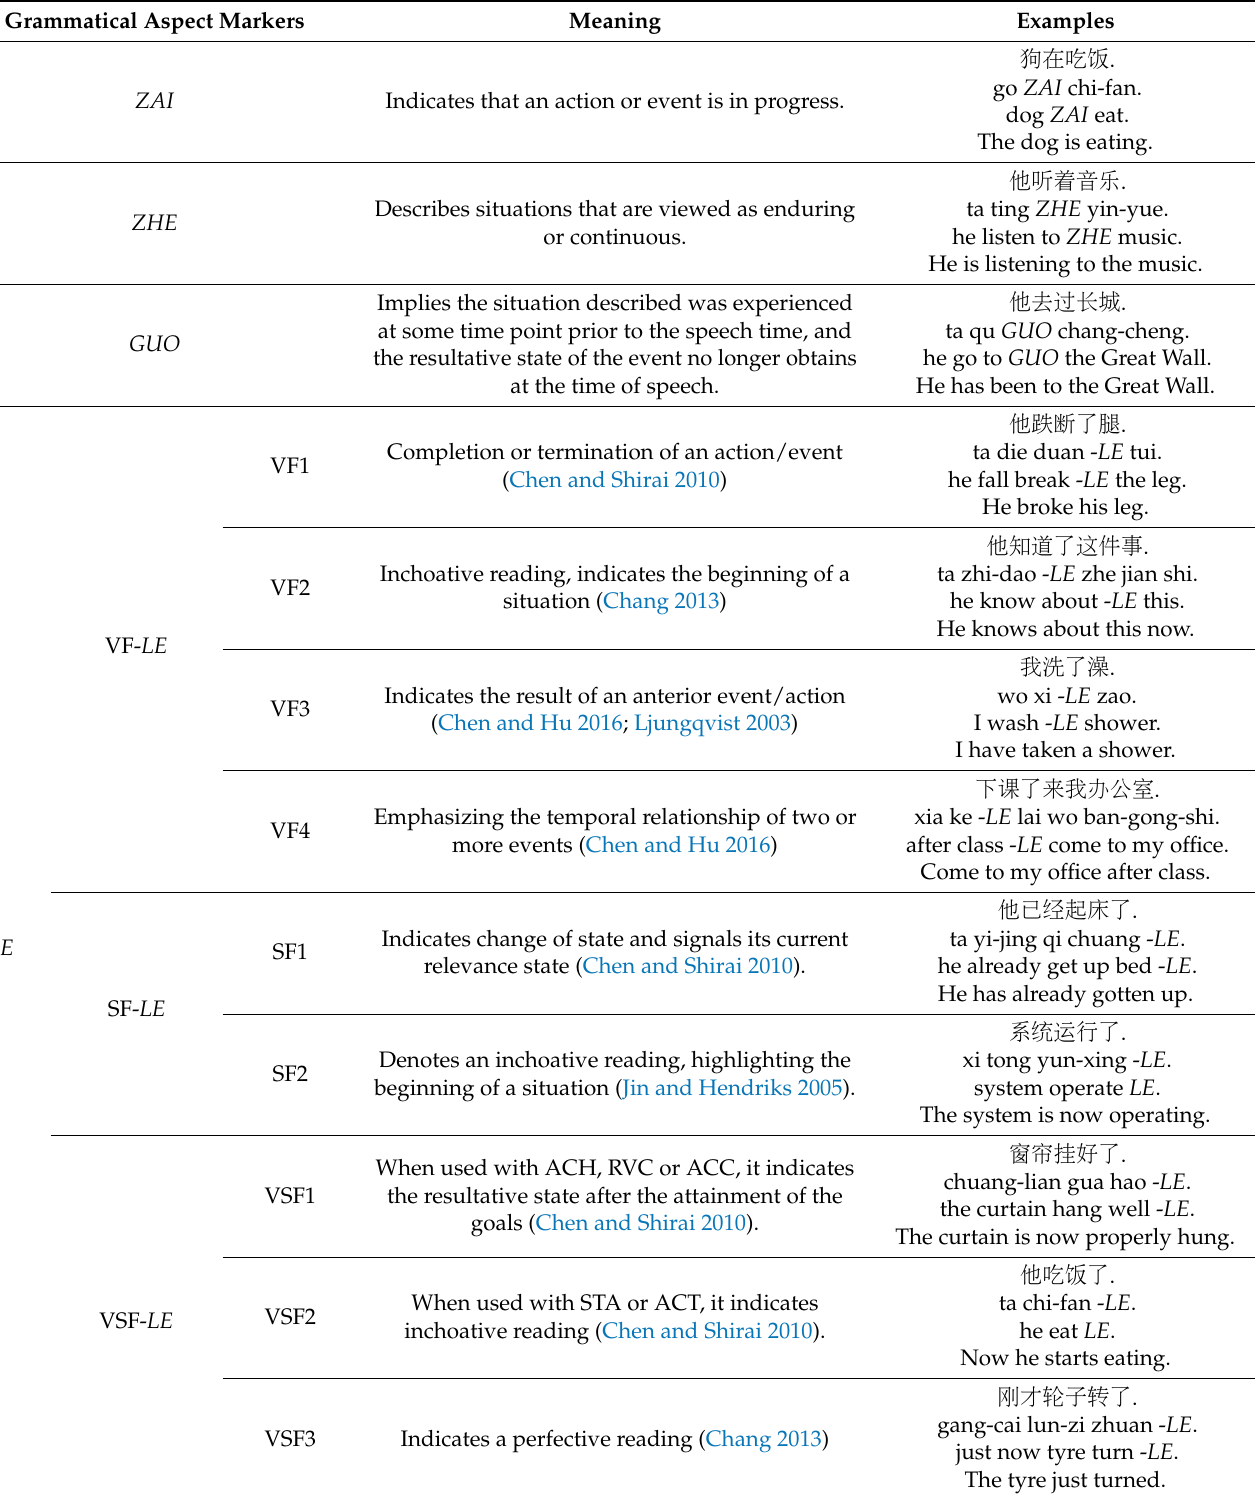
Table 1. Grammatical Aspect Markers in Mandarin